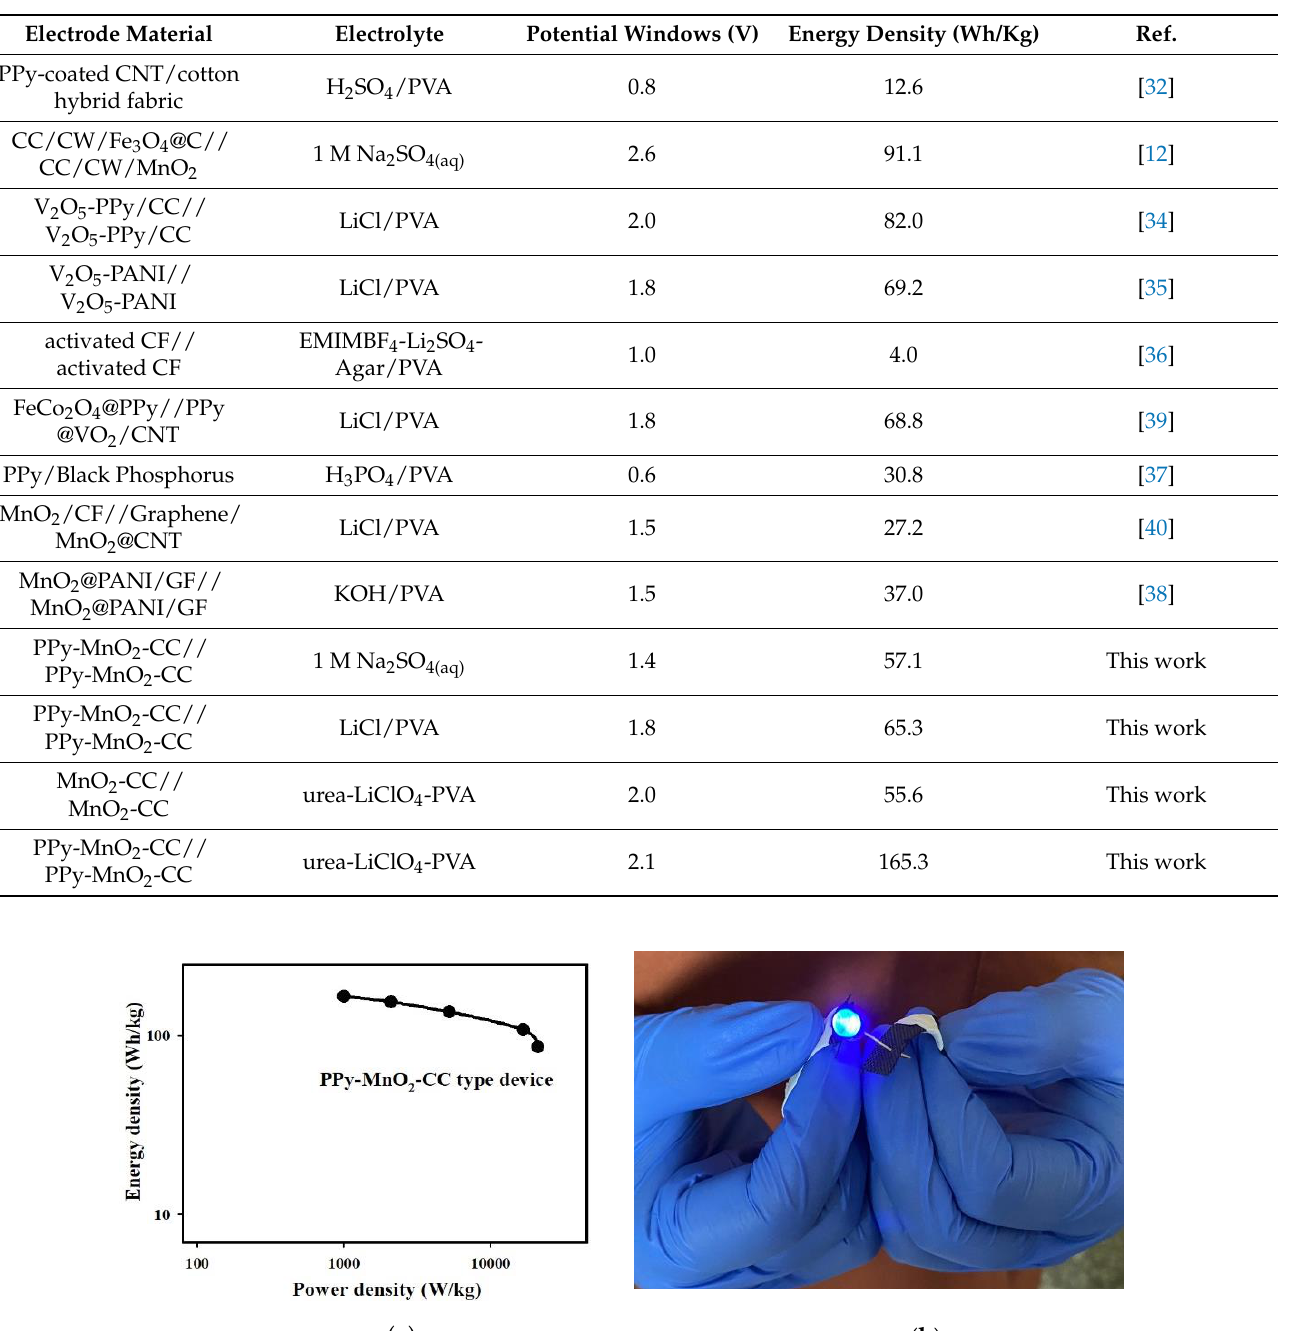
Figure 6. ( a ) Ragone plots of the PPy-MnO 2 -CC flexible SSC device. ( b ) Blue LED operated by a single device.